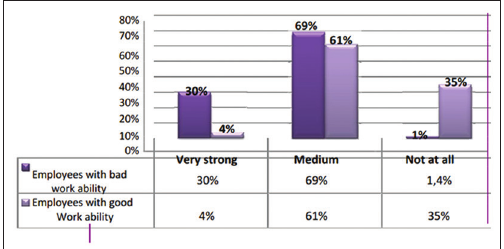
FIGURE 3. Work ability and exposure to health burdens at workplace. Of the total number of 71 (100%) registered employees with suboptimal work ability, 49 (69%) employees perceived medium exposure to health burdens. Very strong exposure was reported by 21 (30%) employees. On contrary only 8 (4%) employees with optimal work ability perceived very strong exposure to health burdens at